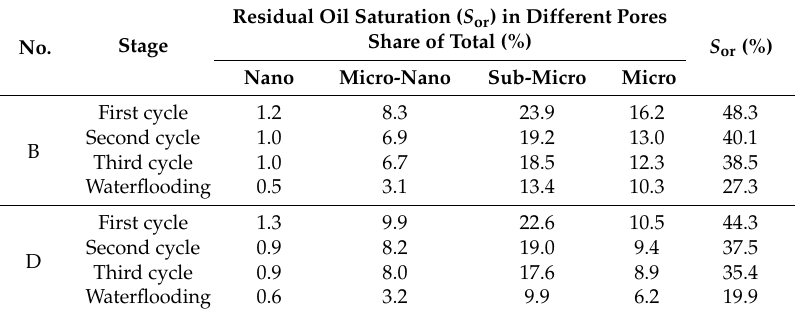
Table 4. Residual oil saturations for the cores and their different pores in the huff-n-puff experiment. Residual Oil Saturation ( S or ) in Different Pores Share of Total (%) S No. Stage or (%)